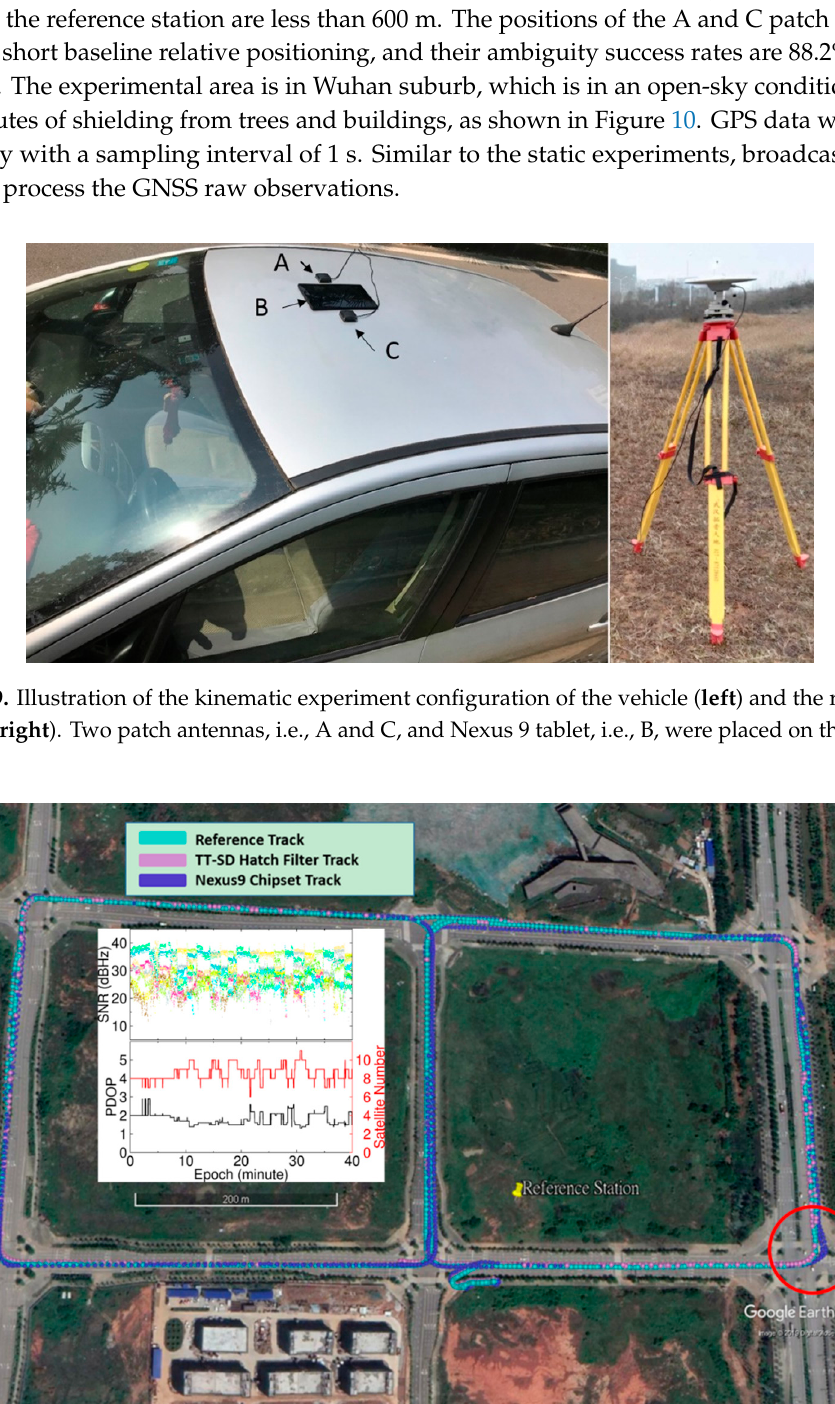
Figure 11. The track of the SPP (Single Point Positioning) solution ( black dots ) and the track of the traditional Hatch filter ( yellow dots ) with a 600s-window solution.